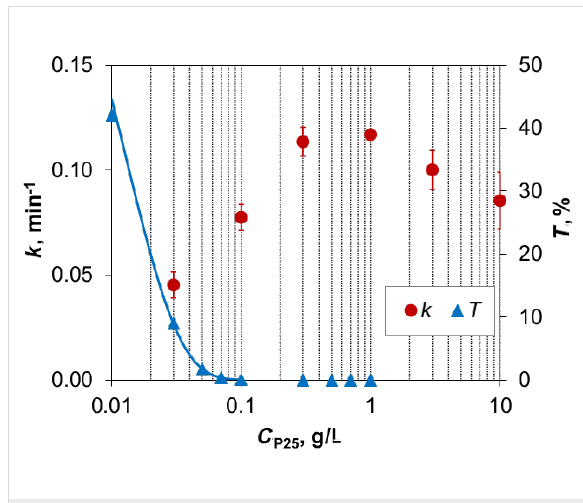
Figure 7: Influence of P25 catalyst concentration on the reaction rate constant and the transmittance through the thickness of the reactor at λ = 365 nm (experiments were repeated two or three times and error bars indicate the standard deviation).